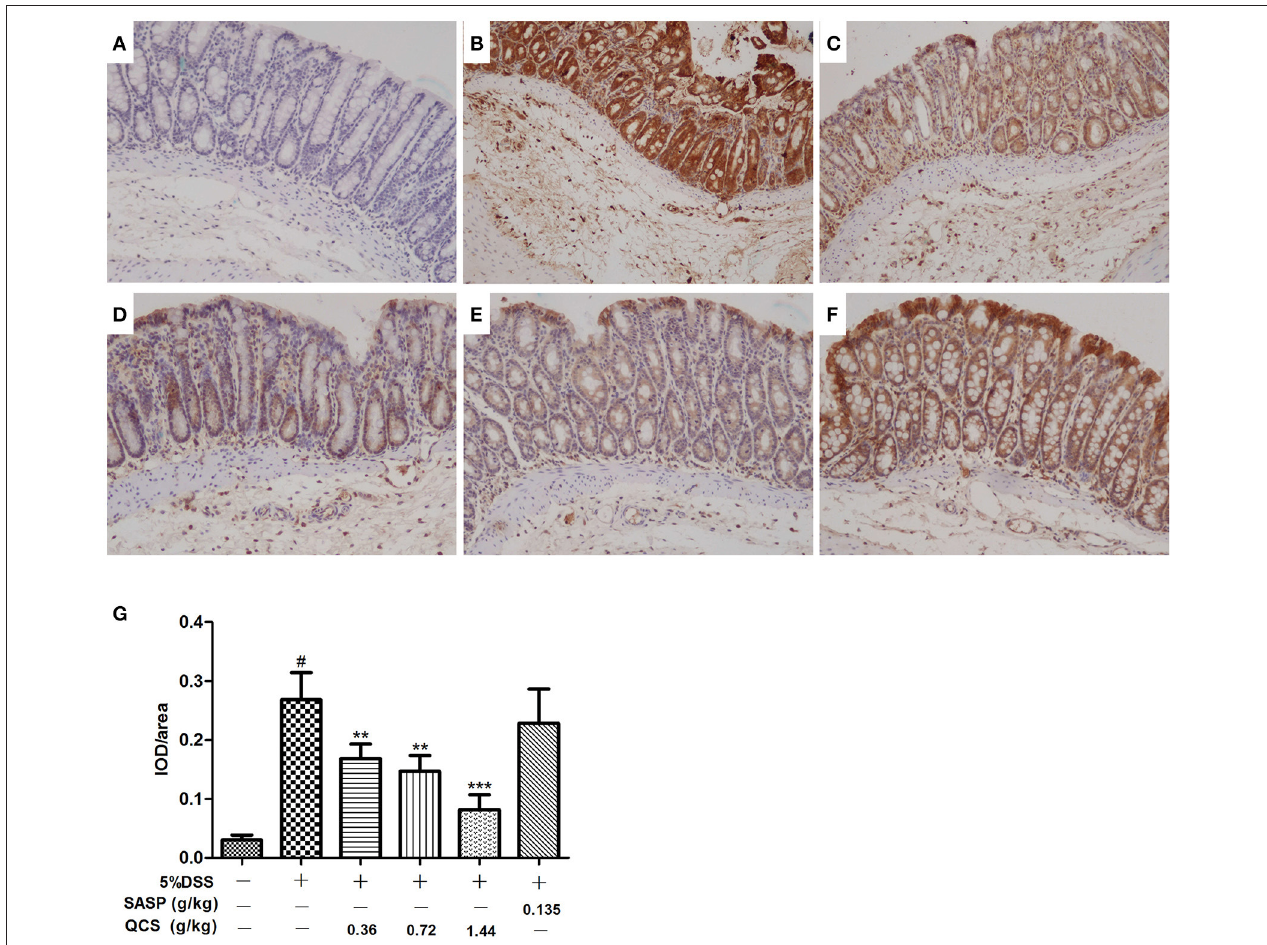
FIGURE 7 | Effects of QCS on DSS-induced colon tissues hypoxia. Visualization of hypoxia in colonic mucosa by Hypoxyprobe-1 staining. Images are representative of three tissue slices (brown staining, × 100). (A) Control; (B) DSS model; (C) QCS 0.36 g/kg; (D) QCS 0.72 g/kg; (E) QCS 1.44 g/kg; (F) SASP 0.135 g/kg. (G) Quantified data of hypoxia in colonic mucosa. The final result was expressed as integral optical density (IOD)/ area of effective statistical. ( n = 6/group). ** P < 0.01; *** P < 0.001, vs. model group; # P < 0.05, vs. control